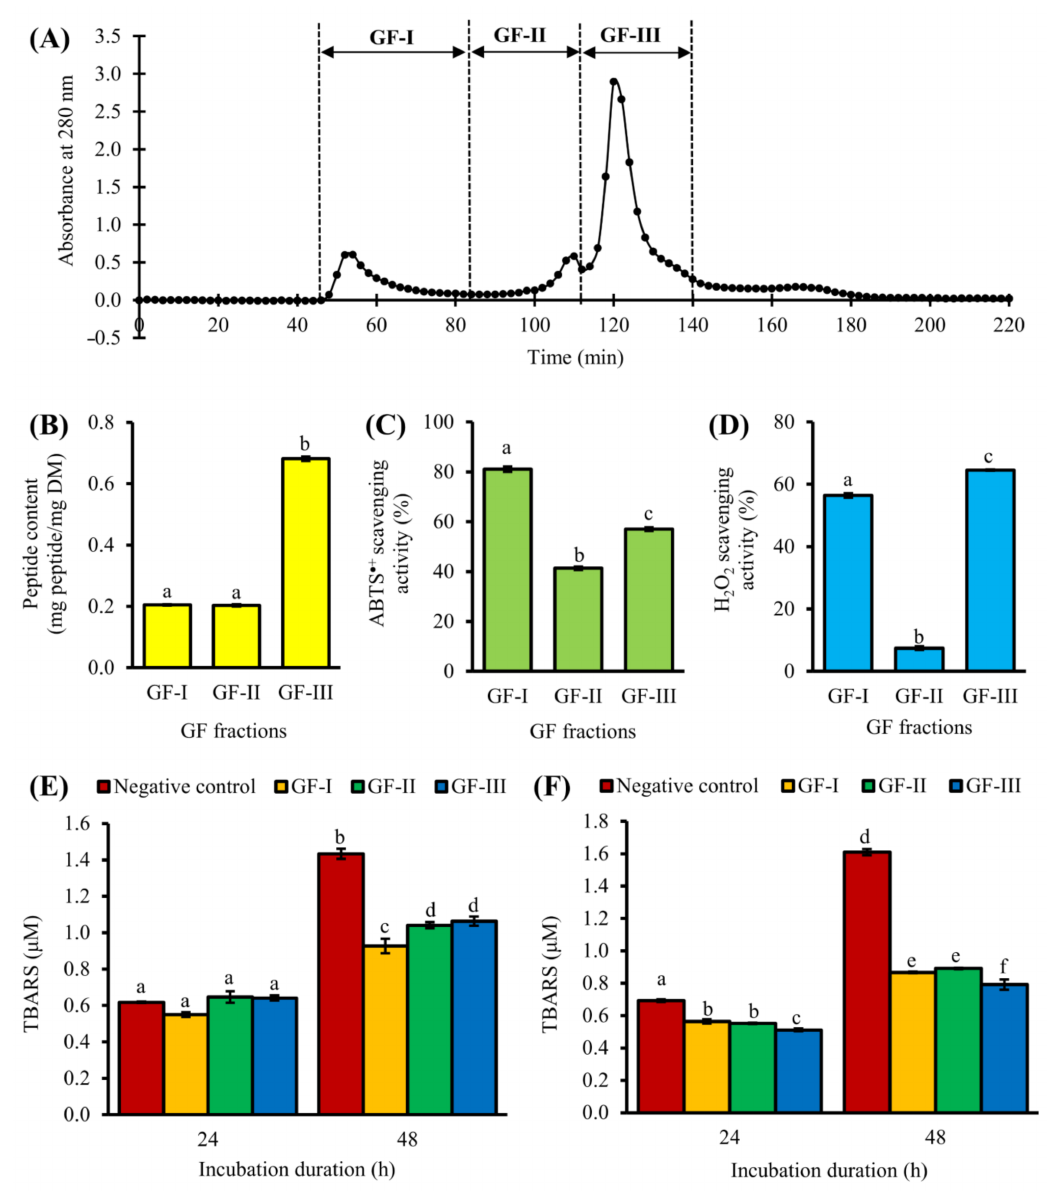
Figure 2. Purification of the <3 kDa fraction by gel filtration chromatography (GFC). ( A ) Elution profile, ( B ) peptide content, ( C ) ABTS • + scavenging activity (at 30 µ g peptide/mL), and ( D ) H 2 O 2 scavenging activity (at 150 µ g peptide/mL) of pooled GFC fractions. TBARS values of negative control and GFC fractions ( E ) at 0.1 mg peptide/mL and ( F ) at 0.5 mg DM/mL. Data are mean ± standard errors ( n = 3). For each bar chart, mean values denoted by different superscript letters are significantly different ( p < 0.05) according to Tukey’s